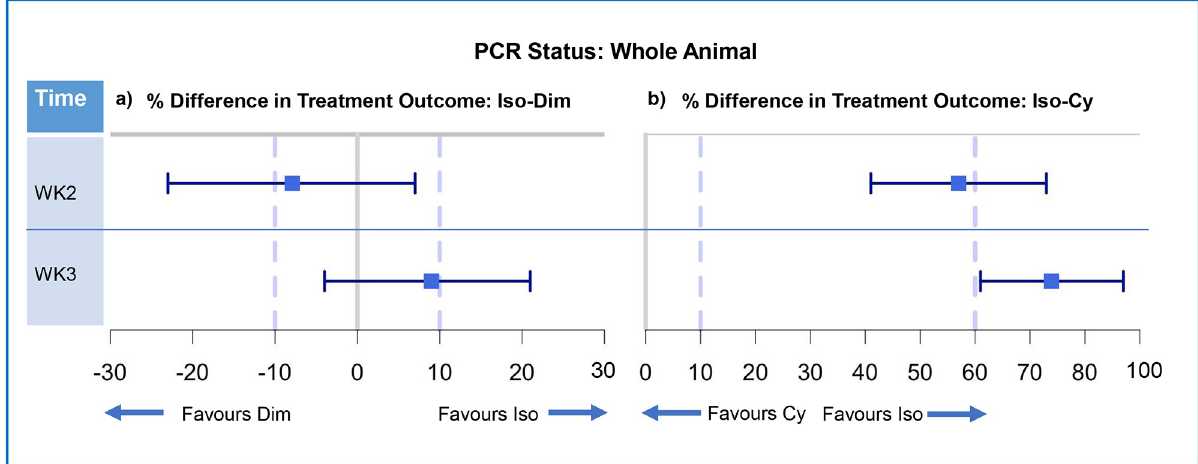
Fig 6. Forest plots illustrating non-inferiority analysis of the outcome of trypanocidal treatment by whole animal. Forest plots illustrating non- inferiority analysis of control drug and test drug for whole animal (n = 162). a) Control (isometamidium) vs test (diminazene) b) Control (isometamidium) vs test (melarsomine dihydrochloride). Positive treatment outcome was defined as a negative PCR result for all Trypanosoma spp. The percentage difference in treatment outcome was presented as a point estimate (blue square) and two-sided 95% confidence intervals (blue bars). Results are presented as whole animal Trypanosoma spp. status by PCR and are divided by time point (week 2 and week 3). The 10% line represents M2, the accepted difference between drugs to demonstrate non-inferiority. The 60% line represents M1, the accepted difference between the drugs to demonstrate effect comparable to